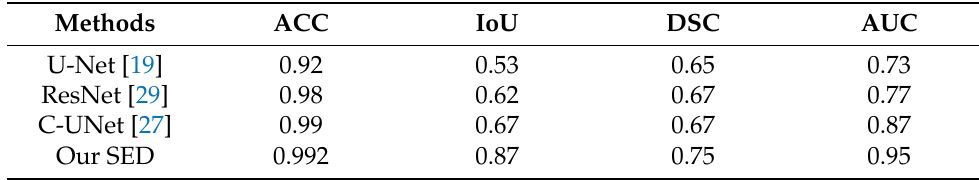
Table 3. Evaluation result by different